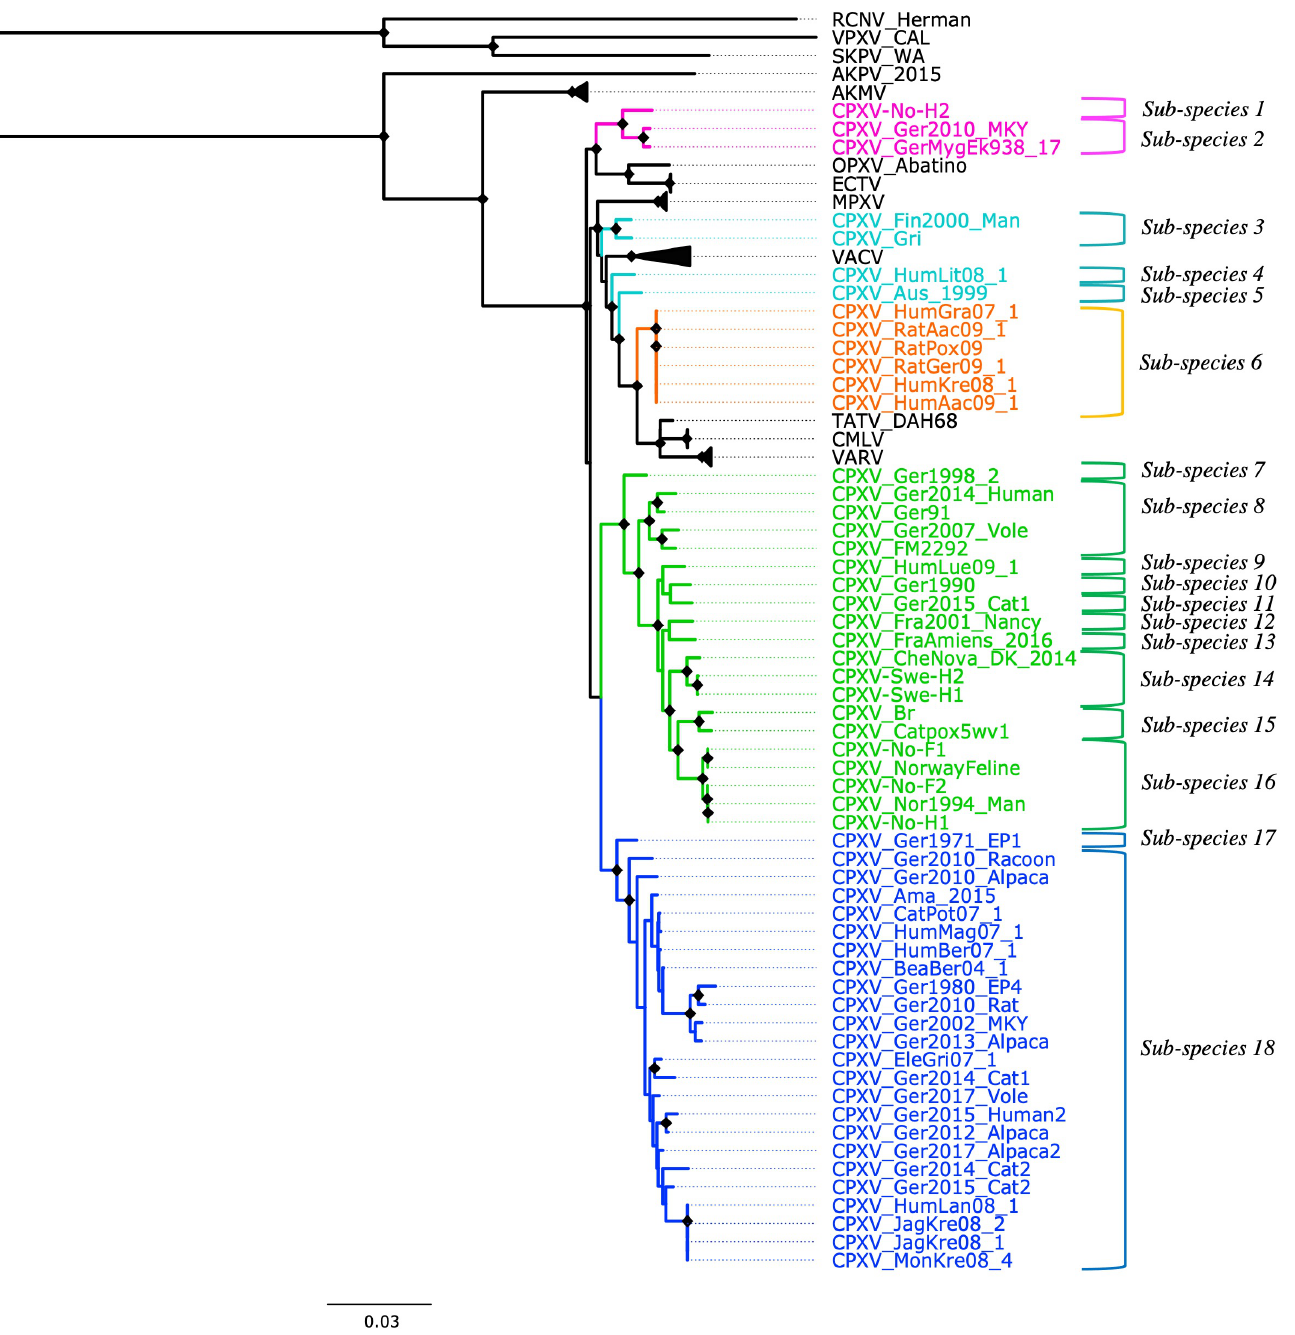
Figure 3. New classification of cowpox virus (CPXV) based on phylogenetic tree inference from 62 conserved genes without evidence of recombination, patristic and genetic distances. Diamonds at the nodes indicate bootstrap values > 80%. The main five CPXV clusters were highlighted in different colors: pink (Ectromelia-Abatino-like CPXV), blue (CPXV-like 1), green (CPXV-like 2), turquoise blue (Vaccinia-like CPXV) and orange (Variola-like